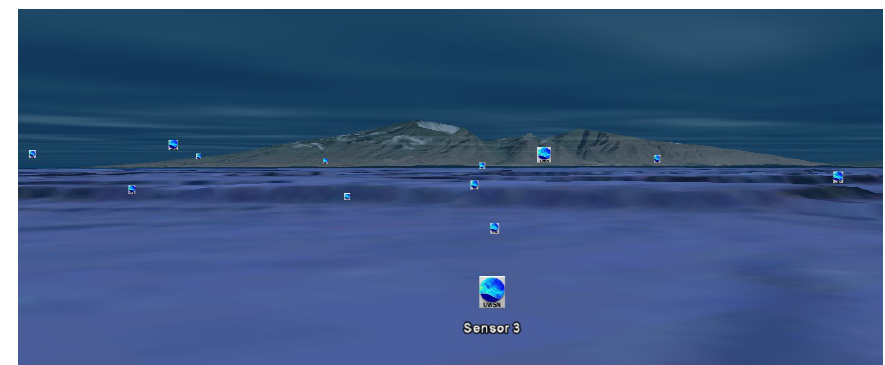
Figure 5. Network deployment 3D (Google Earth TM ).